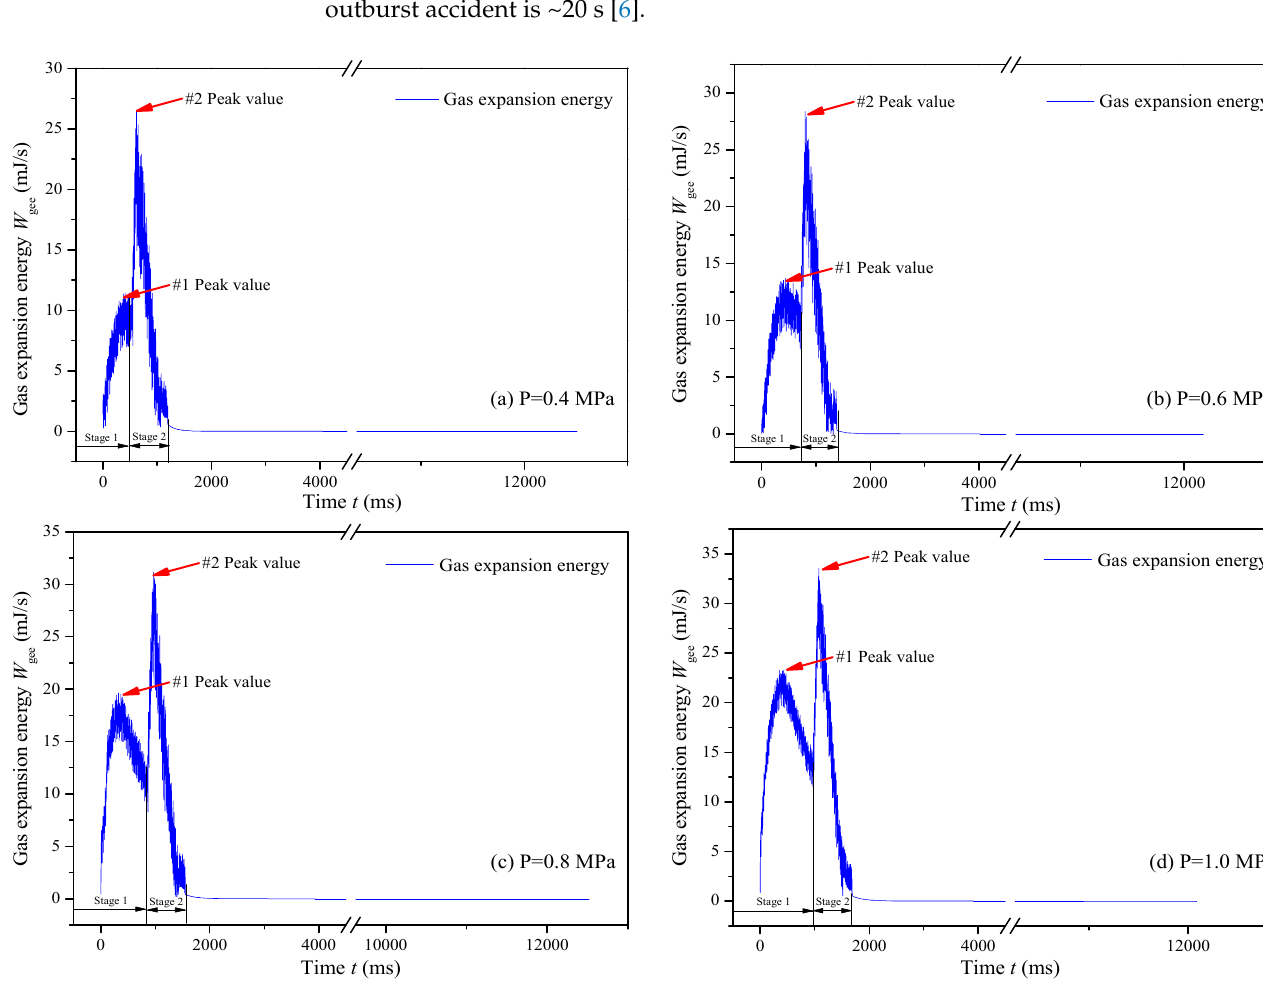
Figure 11. Released process of gas expansion energy from the TD coals with time. In order to further compare and analyze the characterization difference of the released gas expansion energy between the TD and PU coals, as well as the influence mechanism of gas pressure, the change in the two peak values of the two coals with gas pressure is shown in Figure 12, indicating that for PU coal mass the peak values of the TD coal is about 2–3 times of its irrespective of the peak value of #1 or #2. The relationship between the two peak values and gas pressure can be expressed by linear function. The positive correlation between the peak value and gas pressure also confirmed that increased gas pressure leads to more serious damage to the coal mass, which produces greater released gas expansion energy, and then it is the more prone to initiate an outburst. In addition, Figure 3 also demonstrates that the gas desorption produces a high gas pressure gradient near the exposed surface, forming tensile stress exerting to the surface of spallation coal mass. The tensile stress is increased by the increased pressure, and the spallation coal mass is more easily and seriously damaged, resulting in the ejection phenomenon of the small coal blocks and pulverized coals as mentioned in the literature